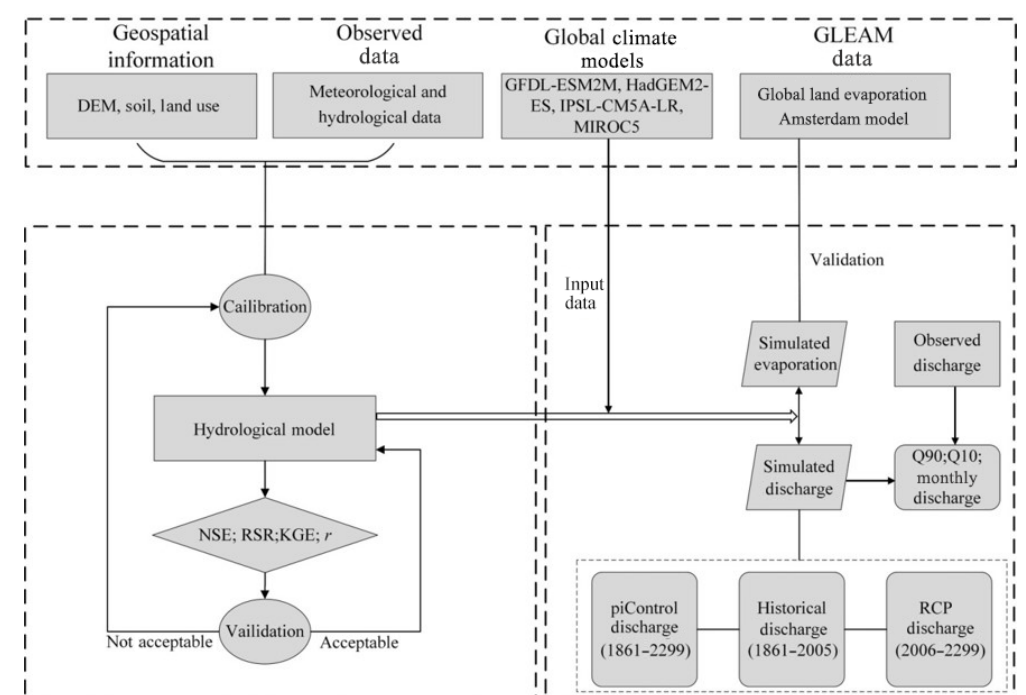
Figure 2. Flow chart for hydrological modelling